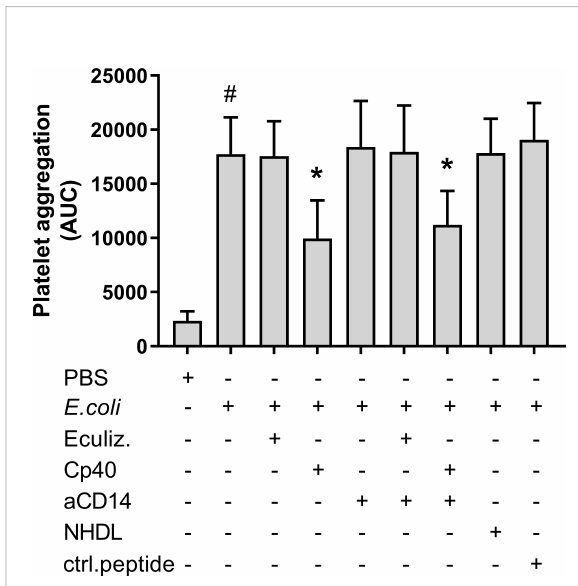
FIGURE 1 Escherichia coli ( E. coli , 5.3 x 10 9 /mL )- induced platelet aggregation measured by Multiplate ® impedance aggregometry. To the samples were added phosphate-buffered saline (PBS) control, eculizumab (Eculiz, 100 µg/mL), compstatin (Cp40, 20 µM), anti-CD14 antibody (aCD14, 15 µg/mL), immunoglobulin G 2/4 control antibody (NHDL, 15 µg/mL) and control peptide (ctrl.peptide, 20 µM) as inhibitors, and PBS or E. coli as